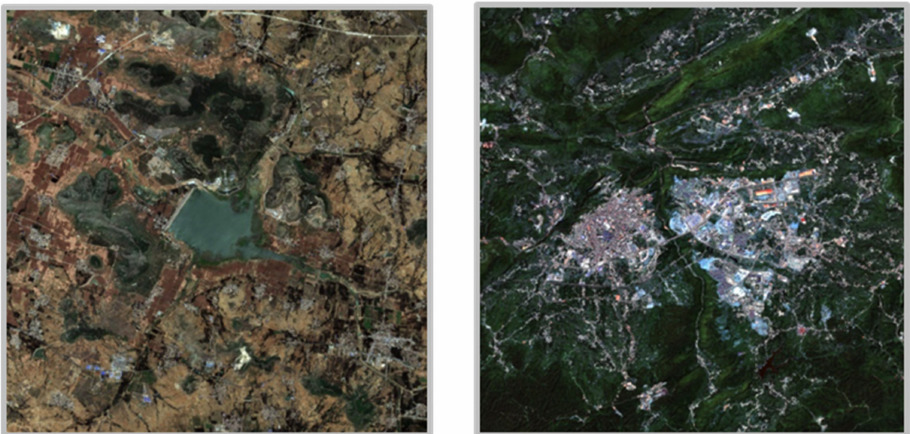
Figure 8. Examples of the input image patches at the first-stage coarse-classification network ( left : aquatic area image, i.e., patch with reservoirs and dam right : land image, i.e., patch with- out reservoirs and